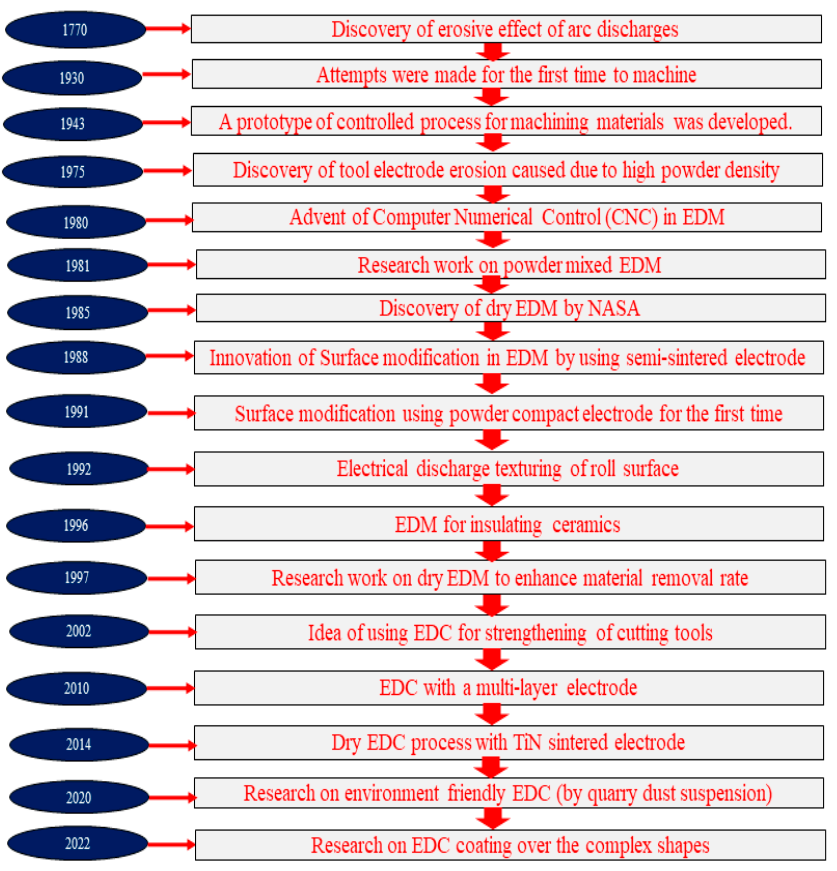
Figure 3. Chronology of EDC origin.